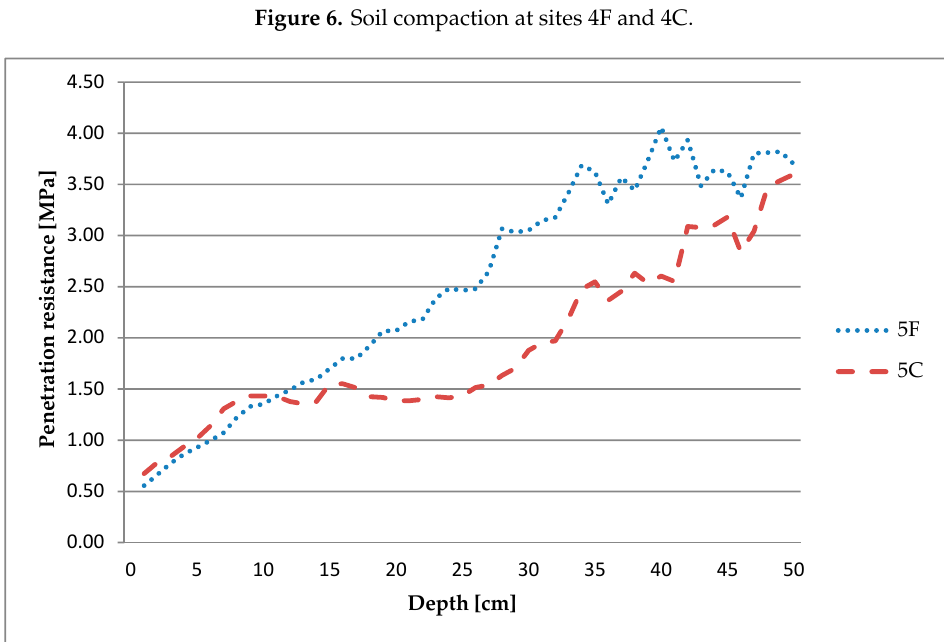
Figure 7. Soil compaction at sites 5F and 5C.